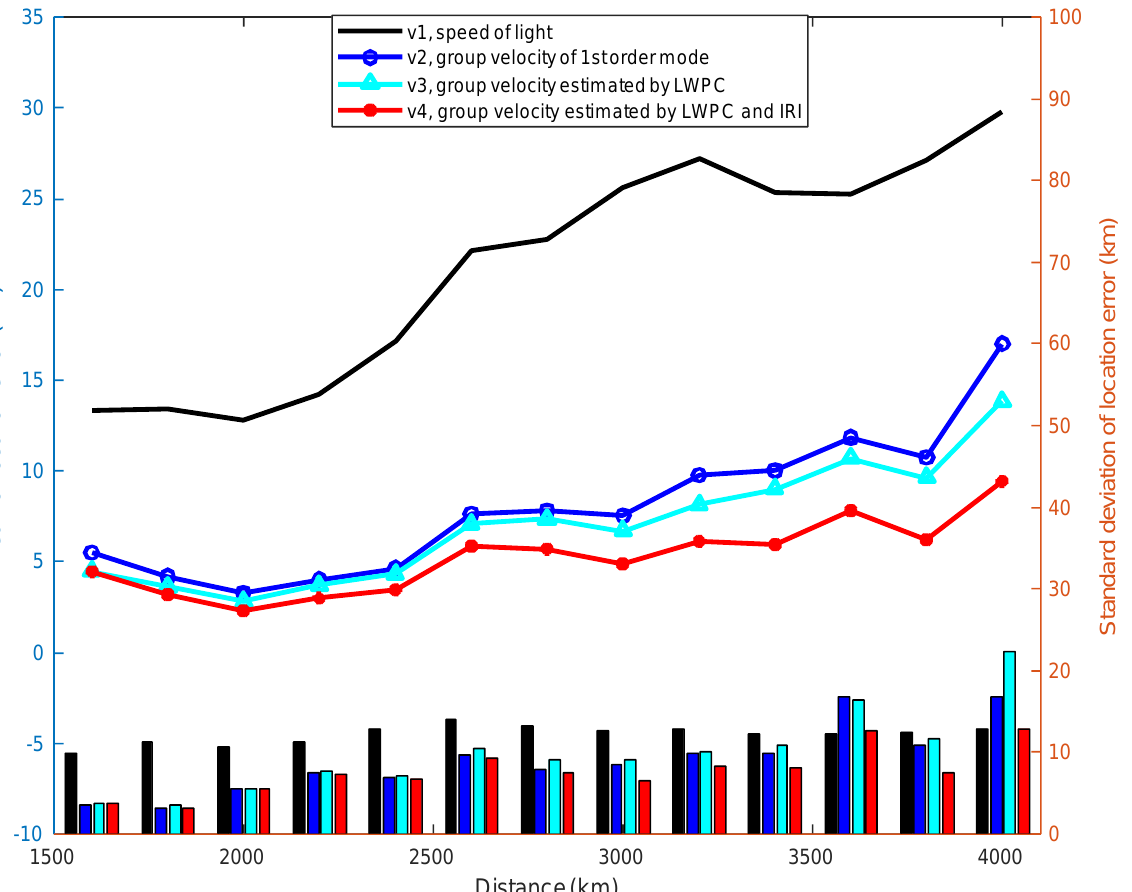
Figure 6. The relationship of lighting location errors with the distance from lightning events to ELLN. The comparison is made among four different methods of group velocity estimation using all of the lightning location results in Figure 3. The curves are the mean values and the bar graphs are the standard deviations, which correspond to the left and right y-axes respectively.